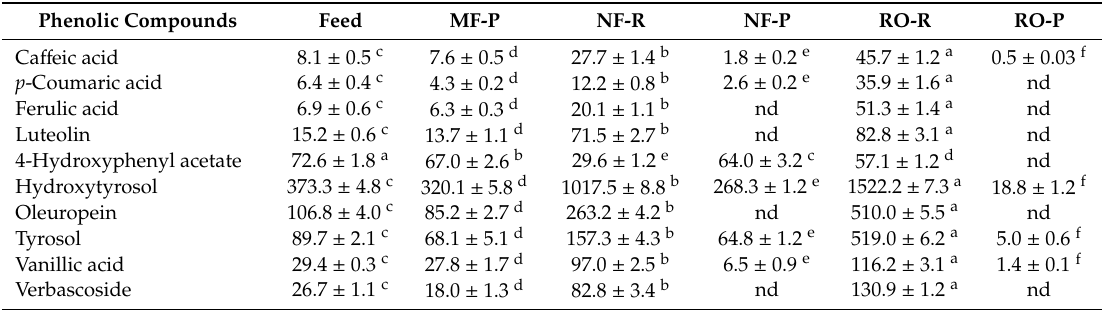
Table 1. Analysis of phenolic compounds (mg / L) in MF, NF and RO samples by UHPLC. Phenolic